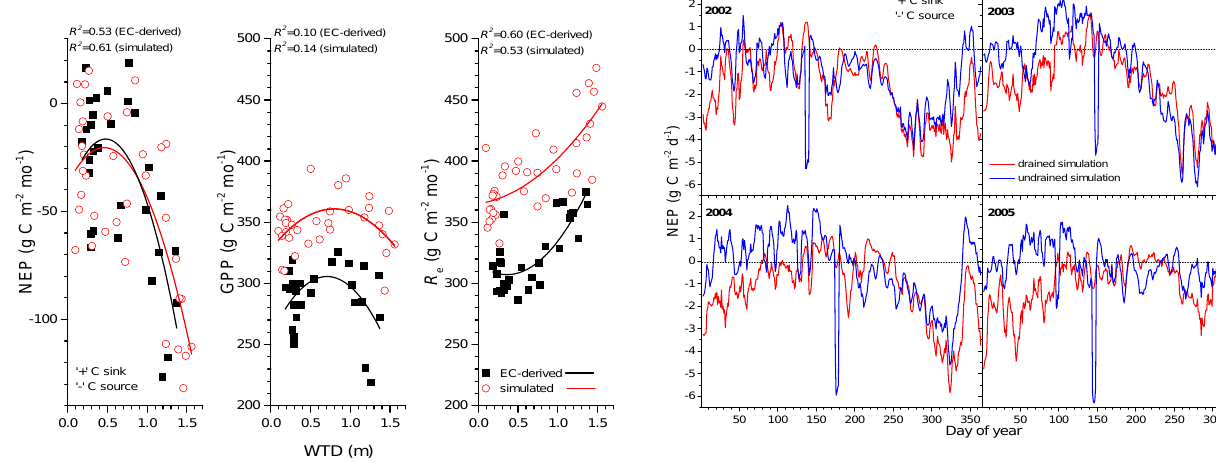
Fig. 8. Relationships between monthly simulated net ecosystem productivity (NEP), gross primary productivity (GPP) and ecosys- tem respiration ( R e ) , and monthly averaged simulated water table depths (WTD) (from Figs. 2c, 3c and 4c for 2002, 2003 and 2004 respectively); and monthly EC-derived NEP (derived from EC-gap filled hourly CO 2 fluxes), GPP and R e (calculated from monthly averaged daily values digitally obtained from Hirano et al., 2007), and monthly averaged observed WTDs (from Figs. 2c, 3c and 4c for 2002, 2003 and 2004 respectively) during 2002–2004 over a drainage affected tropical peat swamp forest at Palangkaraya, In- donesia.